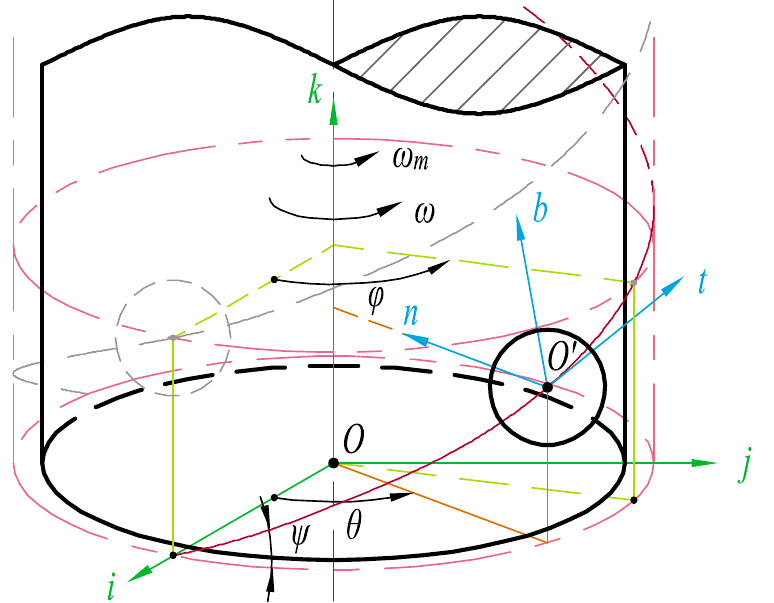
Figure 1. Frenet